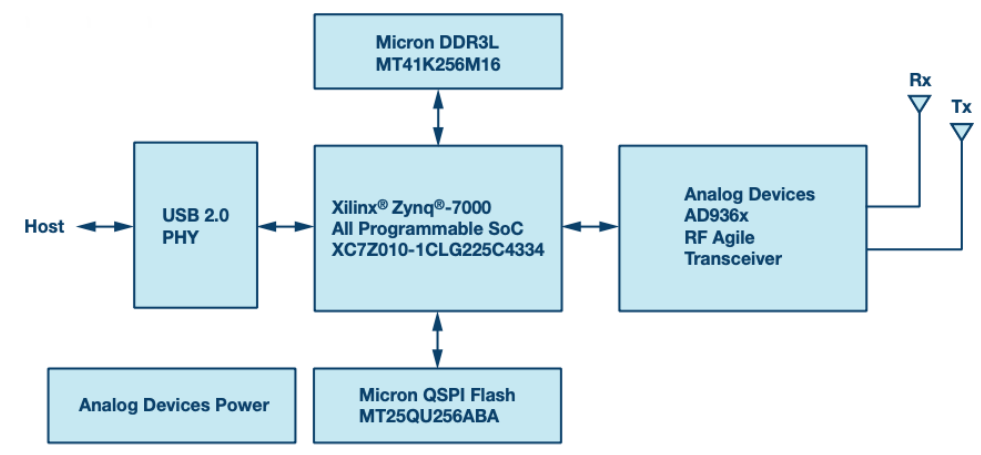
Figure 6. Block diagram representative of the internal architecture of the “Adalm-PLUTO” device.